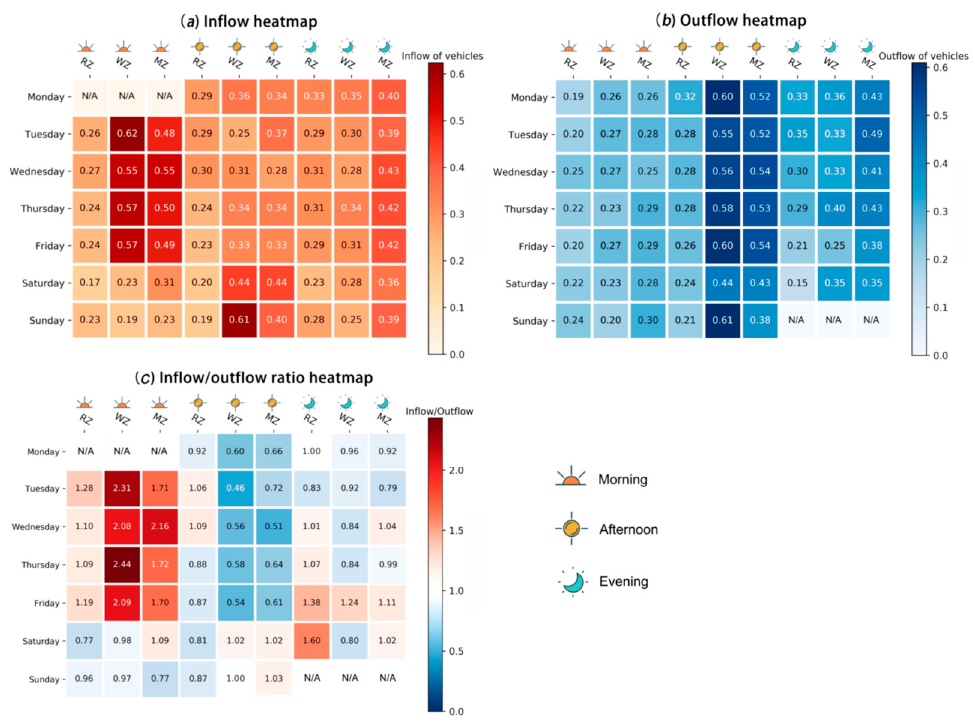
Figure 8. ( a ) Inflow heatmap, ( b ) outflow heatmap and ( c ) inflow/outflow ratio heatmap. Inflow and outflow are both in the form of proportion. Inflow of vehicles is computed using Equation (1) and outflow of vehicles is computed using equation (2). In the subfigure ( a ), the darker the color, the more cars come to park; in subfigure ( b ), the darker the color, the more cars leave. In subfigure ( c ), red means there are more cars coming to park than leaving, while blue means there are more cars leaving. RZ, WZ, and MZ are the abbreviations for residence zone, working zone, and mixed zone.